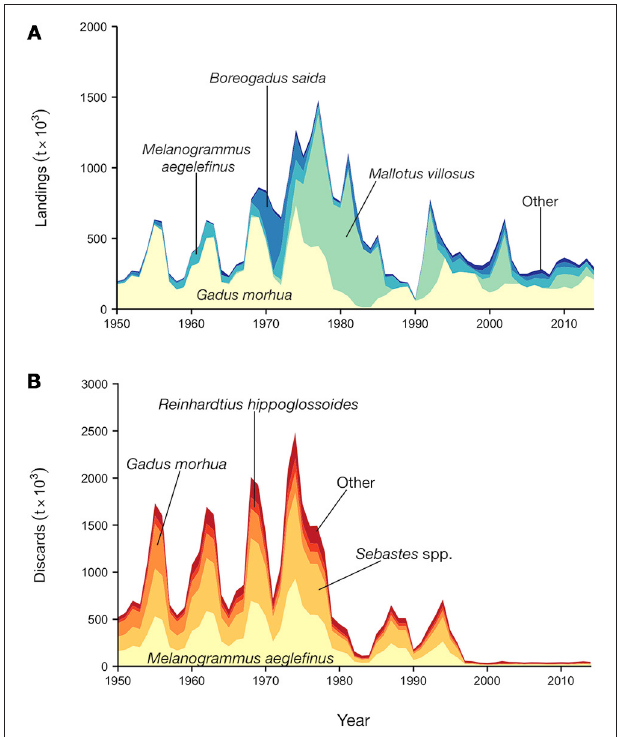
FIGURE 2 | Reconstructed landings for Russia in the Barents Sea with (A) total reconstructed landings from 1950 to 2014 by sector. Small-scale sectors (artisanal, recreational, subsistence) represent less than 1% of landings. Reported data are overlaid as a line graph. (B) Unreported artisanal, recreational, and subsistence landings, i.e., the “small-scale” component from (A) , here expanded for clarity.